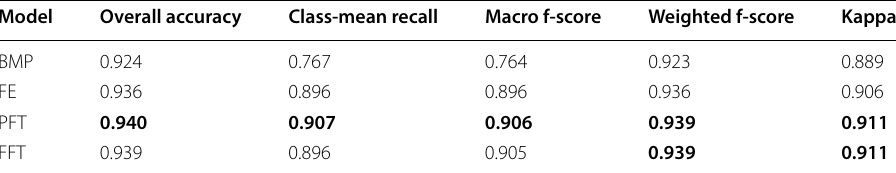
Highest performing values are highlighted in bold